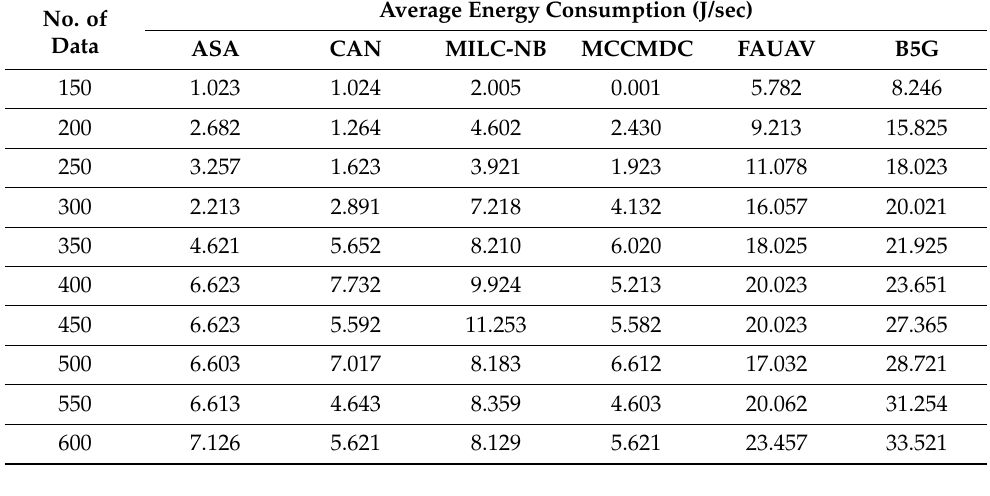
(ASA) algorithm. Table 2. Analysis of Average Energy Consumption.